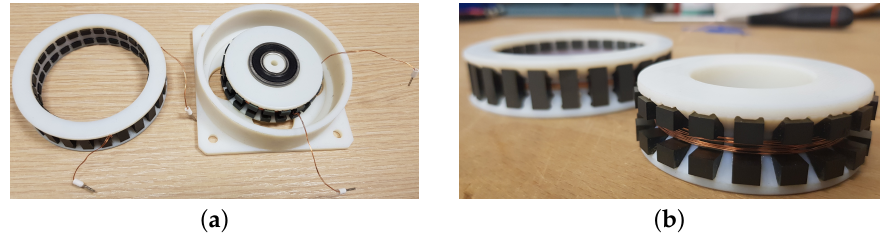
Figure 11. Reduced-size prototype. Both ( a , b ) allow us to appreciate some details in the realization of the core and the windings.